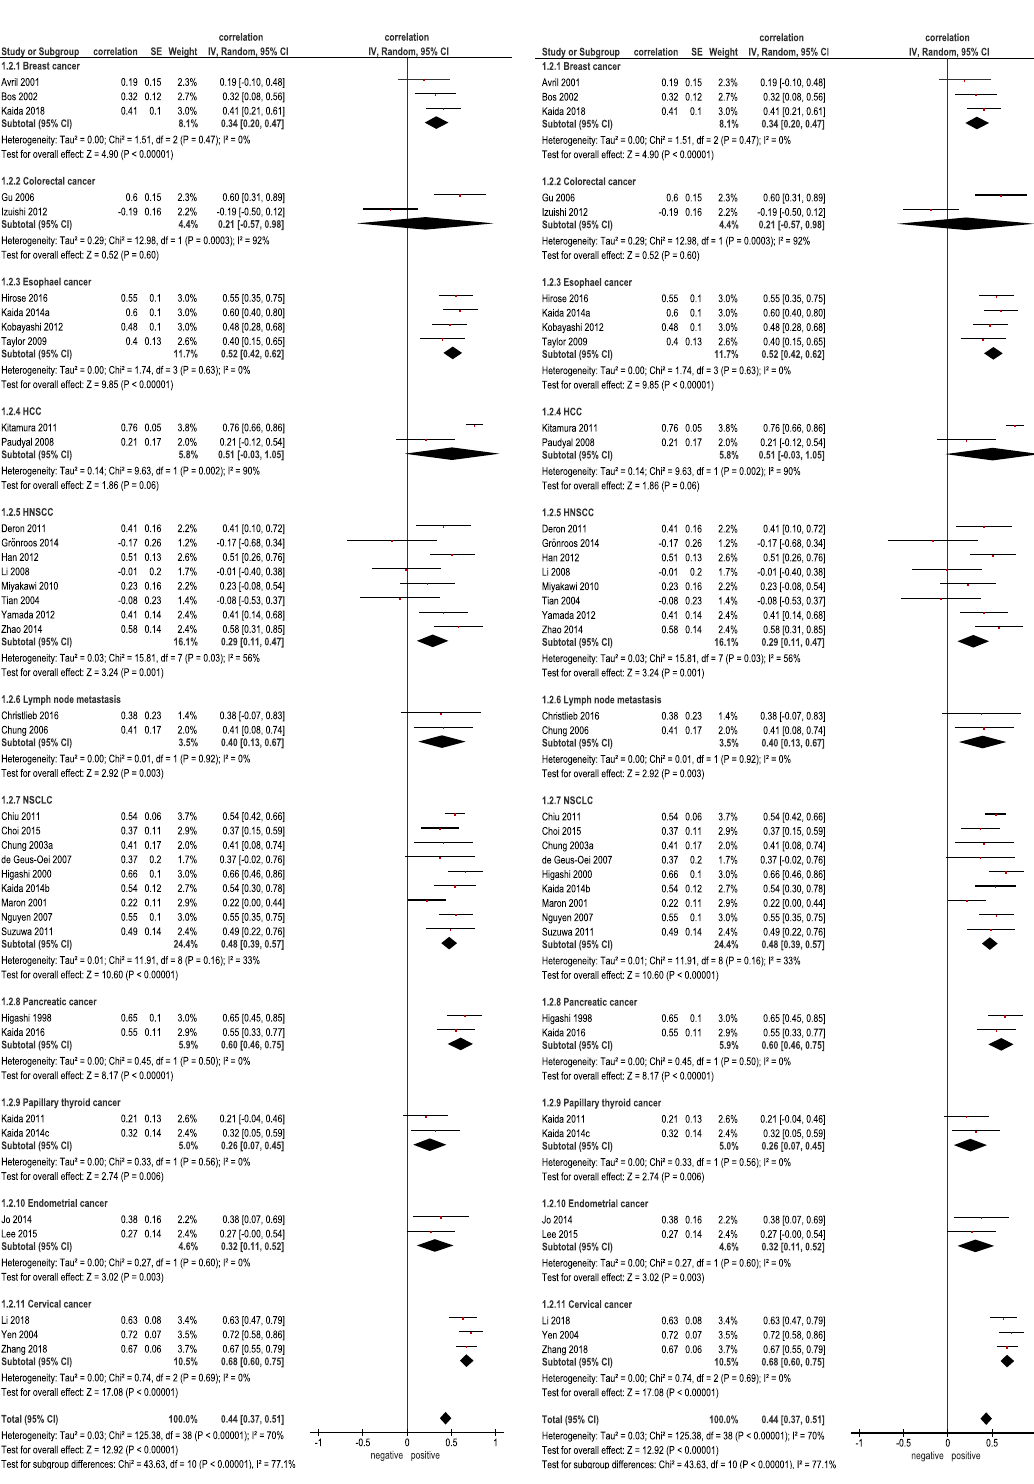
PLOS ONE | https://doi.org/10.1371/journal.pone.0217781 June 17,